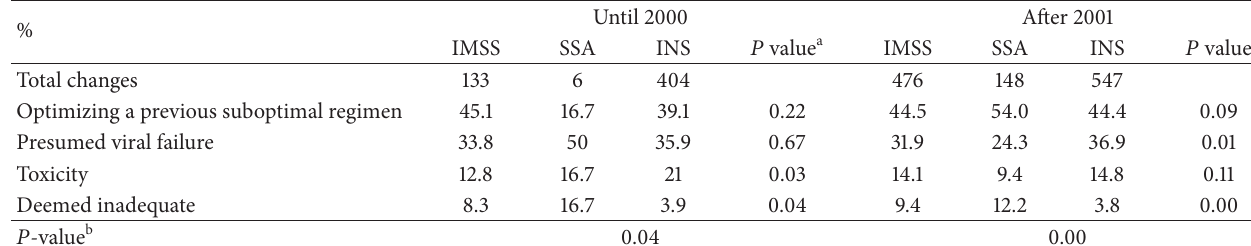
Table 3: Reasons for therapy change by subsystem and period of